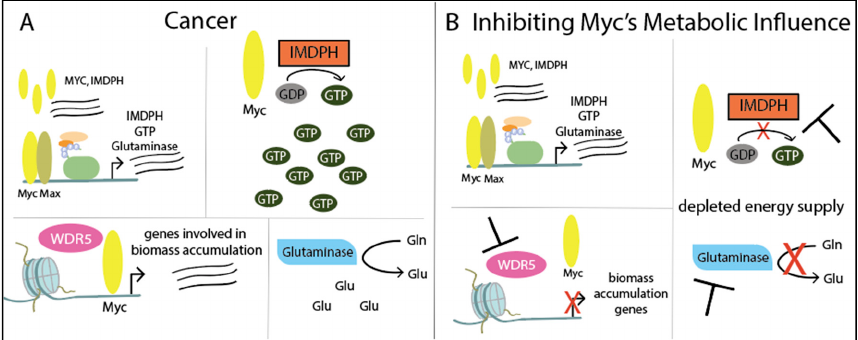
Figure 7. Myc influences metabolism through its target genes: ( A ) In cancer, MYC overexpression correlates with IMPDH expression and transcribes other target genes, including GTP and glutaminase ( GLN ). IMPDH catalyzes GDP to GTP and glutaminase converts glutamine (Gln) to glutamate (Glu), a major energy source in cancer. Lastly, epigenetic co-factor WDR5 recruits Myc to chromatin to express genes involved in biomass accumulation. ( B ) Although Myc still has control over target genes IMPDH , GTP , and GLN , the function of these proteins can be inhibited. Cancer’s energy supply can be depleted by inhibiting IMPDH, which prevents GTP production, or by inhibiting glutaminase, which will limit the pool of glutamate. Finally, inhibiting WDR5 will prevent Myc’s target gene expression of biomass related